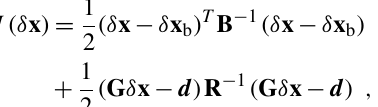
(i.e. standard deviation, dashed lines) and systematic compo-